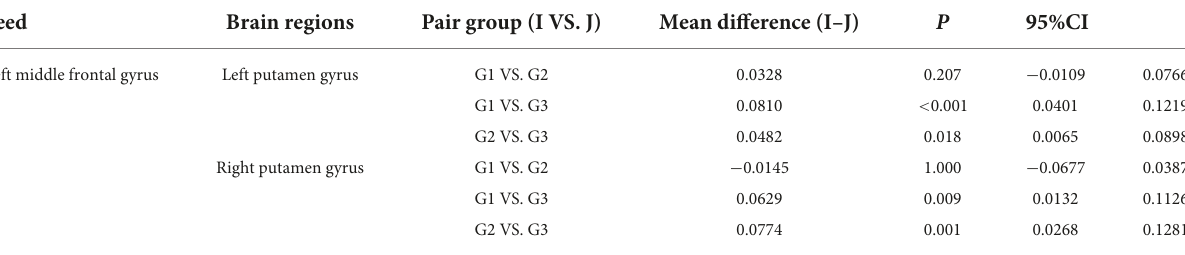
TABLE 5 Multiple comparisons of functional connectivity between left middle frontal gyrus seed and left putamen gyrus and right putamen gyrus. Seed Brain regions Pair group (I VS. J) Mean difference (I–J) 95%CI Left middle frontal gyrus Left putamen